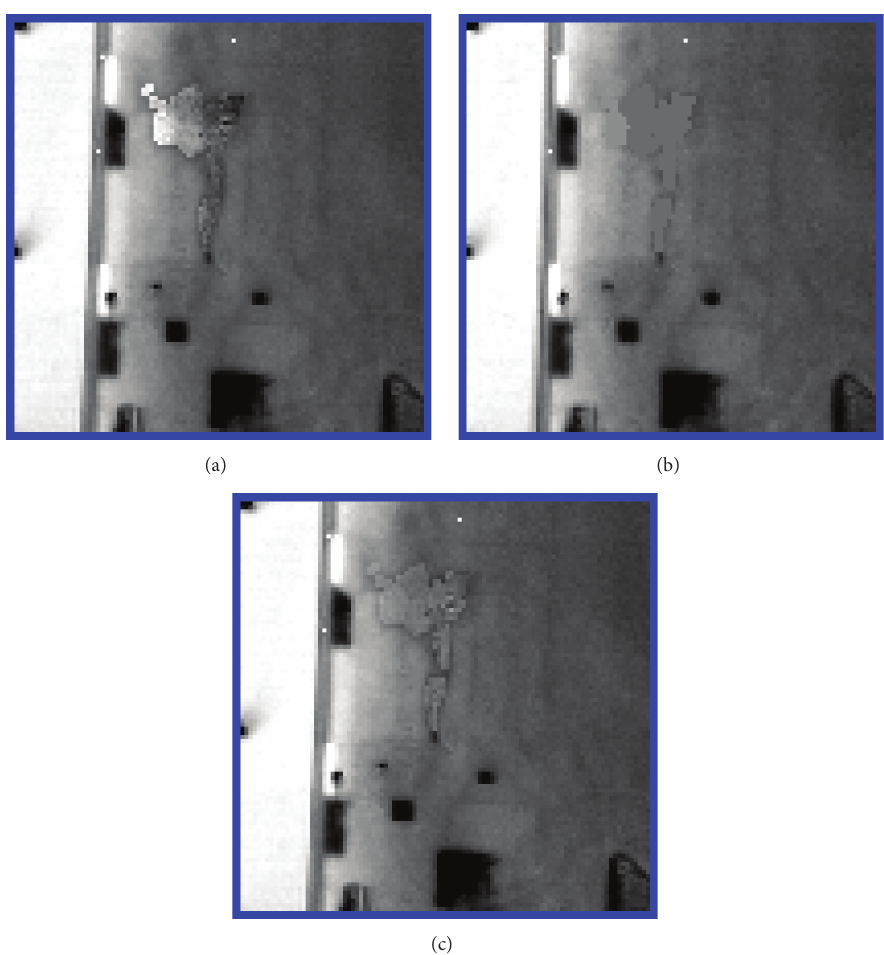
Figure 17: Comparison of the three background radiance estimations according to the band 950.4 cm −1 , where the ethylene absorbance is the most important. (a) Selected-Band approach. (b) Clustering-Based method. (c) Clustering-Based Selected-Band method.